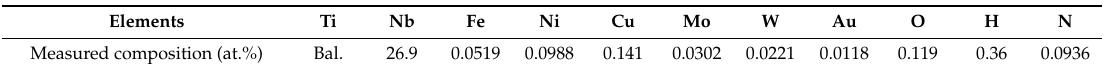
Table 1. Compositions of the Ti–27Nb